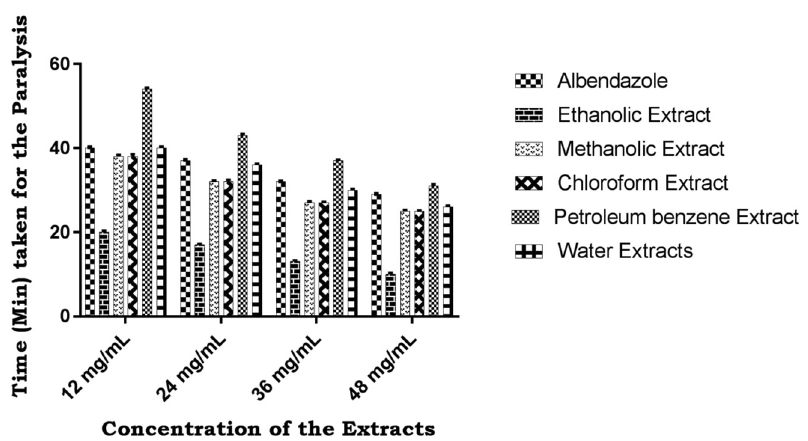
Figure 1: Paralytic activity of P. posthuma treated upon D. viscosa .